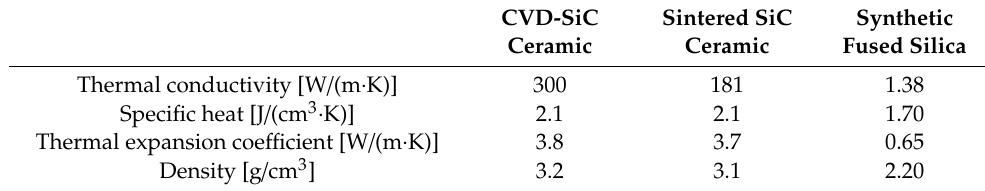
Table 1. Properties of optics substrate